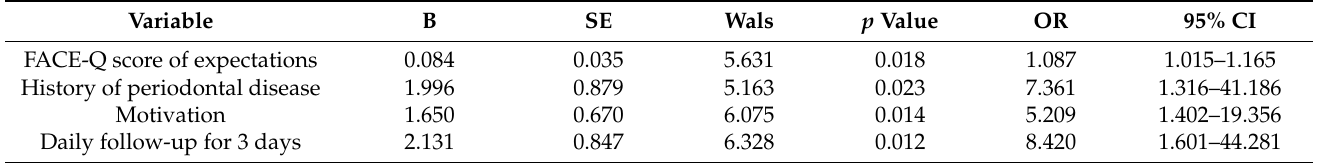
Table 5. Logistic regression of predictors of patient satisfaction after midface